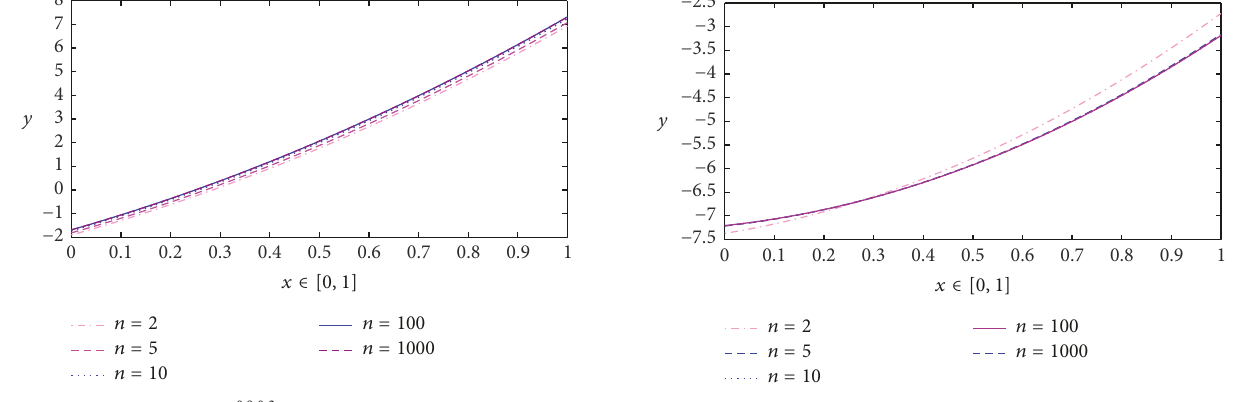
Figure 1: The difference 𝐷 0.8,0.3 𝑛,𝛼,𝛽 (𝑓,𝑥) − 𝑓(𝑥) for 𝛼 = 5 , 𝛽 = 20 , and 𝑓(𝑥) = 9 − 6𝑥 − 3𝑥 2 .